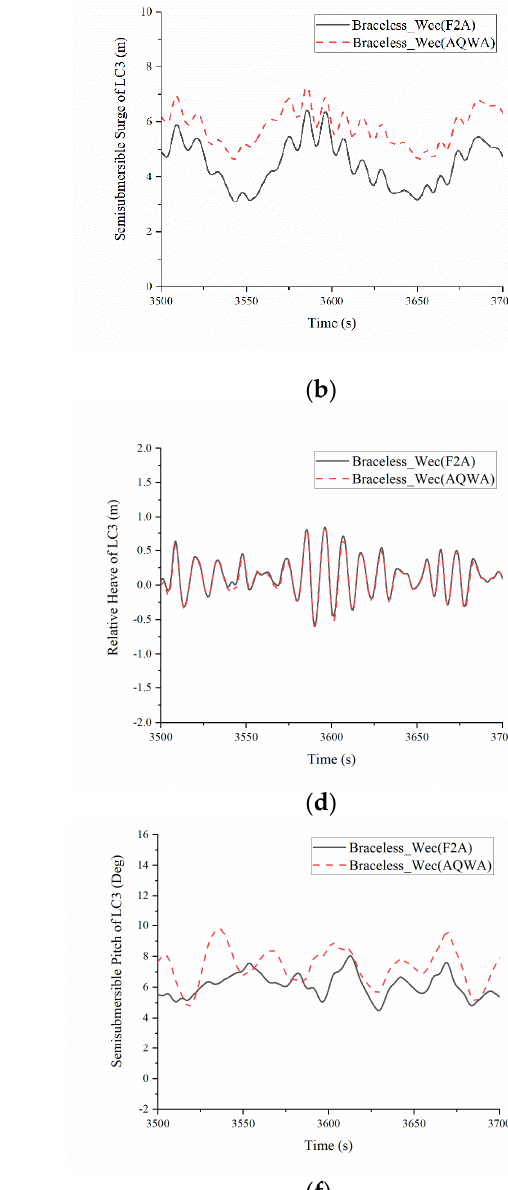
( b ) ( c ) Figure 9. Motion responses of the semisubmersible platform in LC4: ( a ) Surge; ( b ) Relative Heave; ( c ) Pitch.